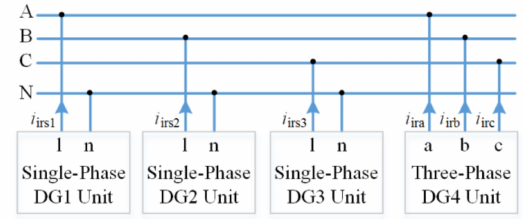
Figure 7. Hybrid of single-phase and three-phase DG.